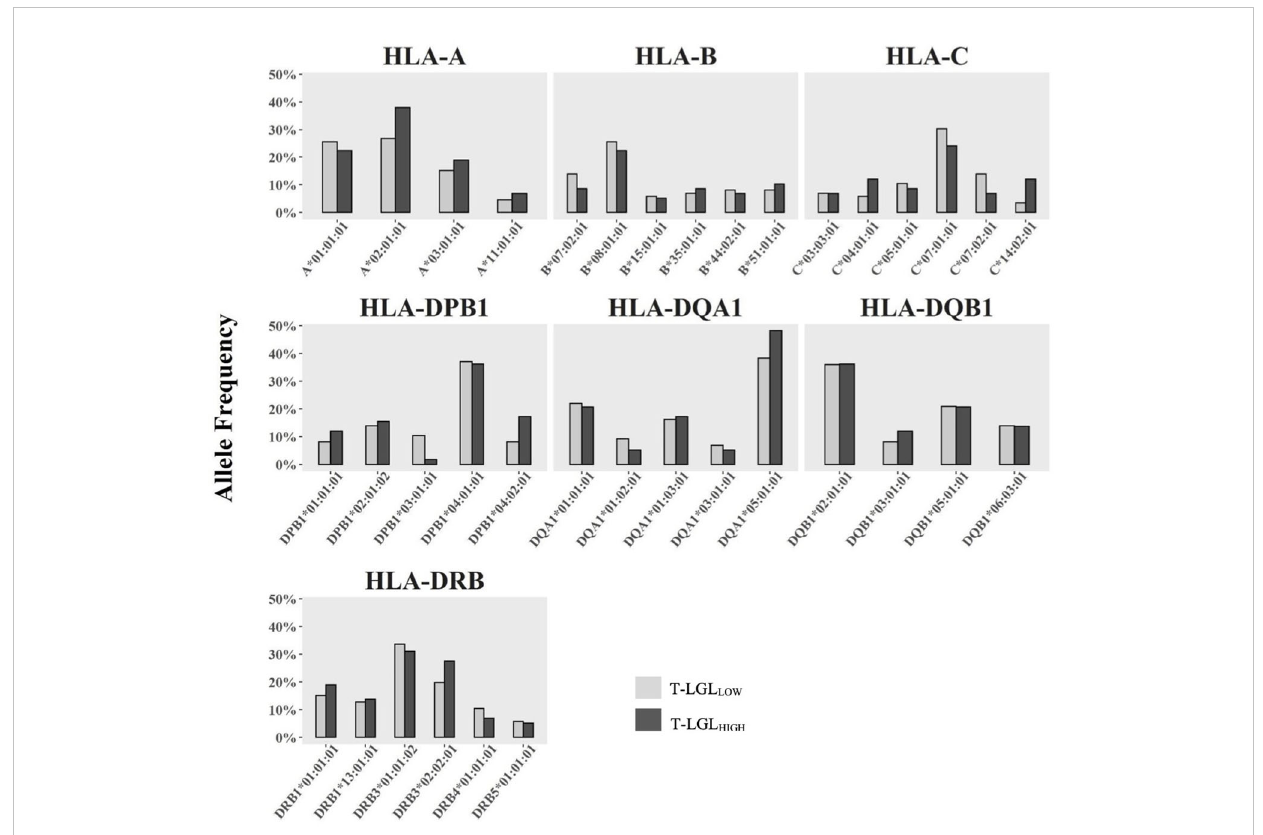
FIGURE 8 Comparison of HLA Class I and Class II allele frequency (%) between IBM T-LGL LOW and IBM T-LGL HIGH patients. Comparative analysis of HLA allele frequencies in 43 T-LGL LOW and 29 T-LGL HIGH IBM patients was performed using the Fisher ’ s exact test. Minor alleles present at a frequency less than 5% in either group were